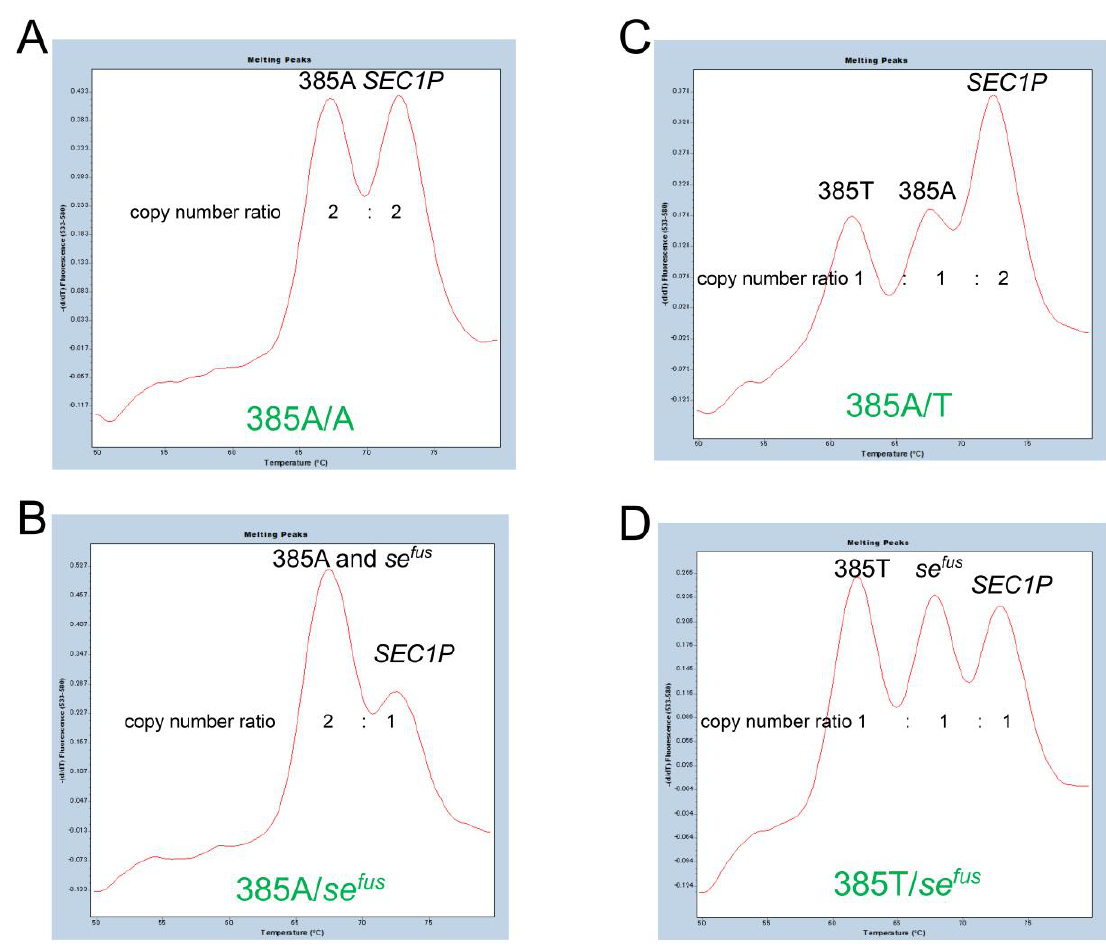
Figure 3. Melting peak profiles of FMCA for four selected subjects with or without se fus . Melting peak profiles of 385A/A ( A ), 385A/ se fus ( B ), 385A/T ( C ), and 385T/ se fus ( D ). The copy number ratio of each peak is indicated.